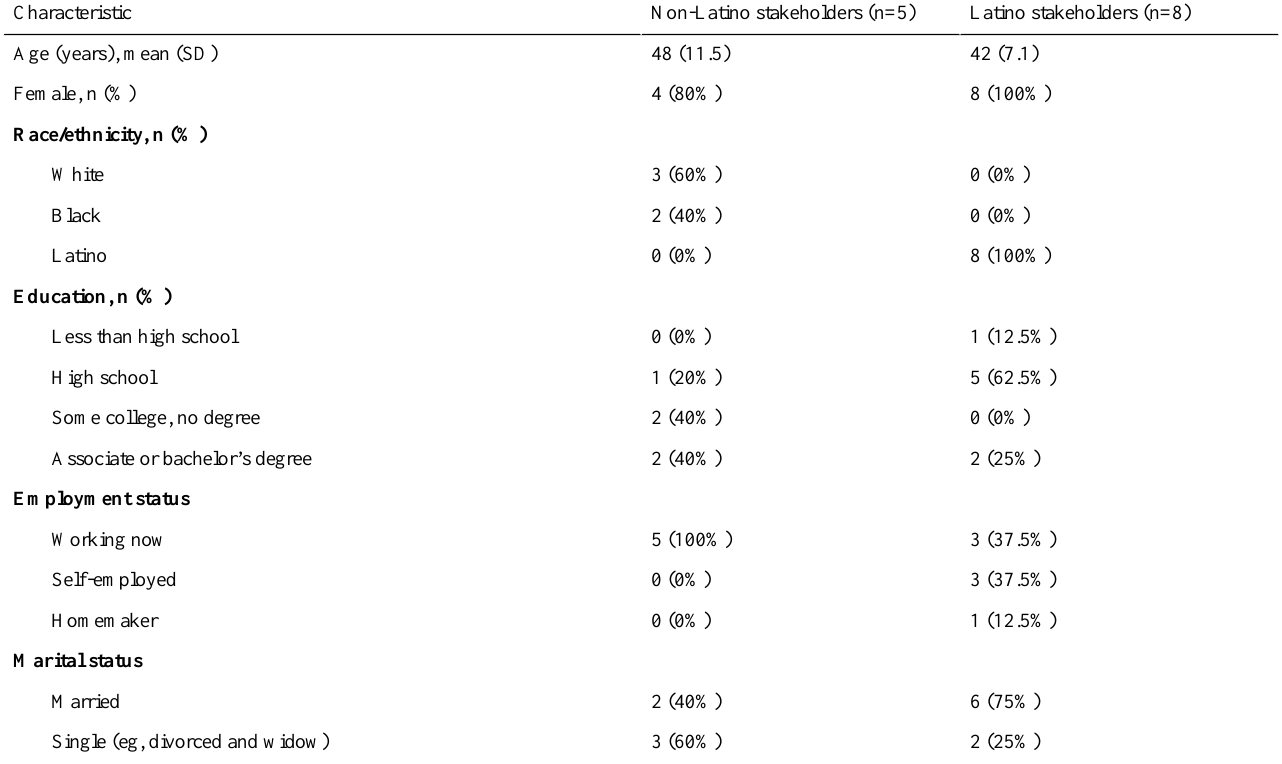
Table 1. Characteristics of non-Latino and Latino stakeholders (parents and clinical